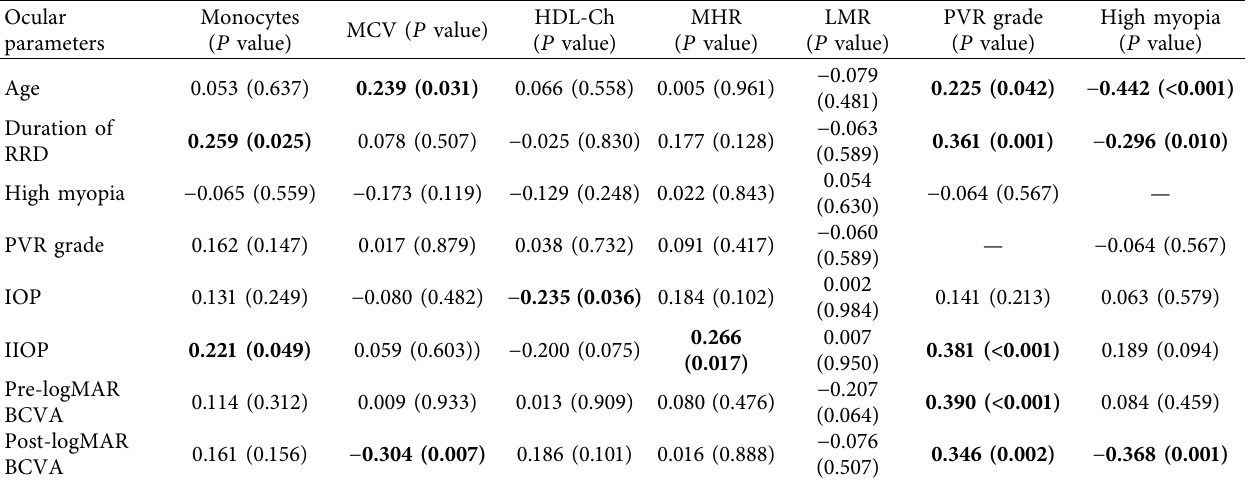
Table 2: Spearman correlation between monocytes, MCV, HDL-Ch, MHR, LMR, and main clinical features in RRD patients. Ocular